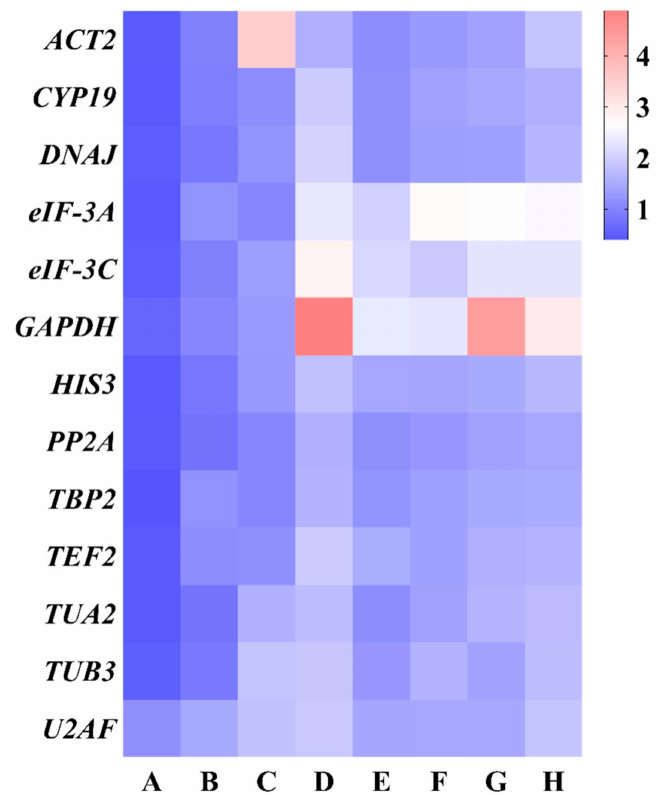
Figure 7. Expression stability for 13 candidate reference genes calculated via Delta Ct. ( A ) Di ff erent genotypes, ( B ) di ff erent developmental stages, ( C ) di ff erent tissues, ( D ) salt stress, ( E ) heat stress, ( F ) cold stress, ( G ) osmotic stress, and ( H ) all samples. Low to high expression stability is represented over a spectrum from red to blue,